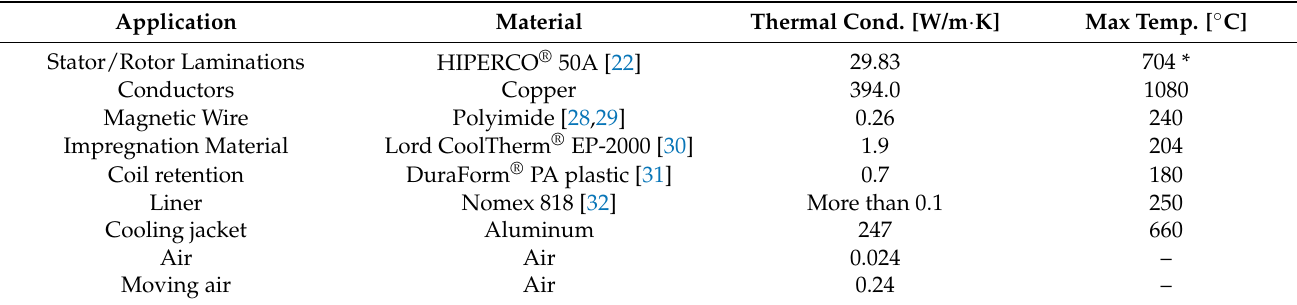
Table 8. Thermal Conductivity Characteristics for